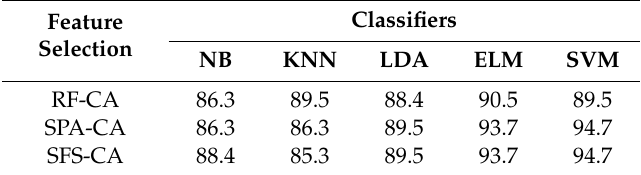
Table 2. The classification results of models based on the optimal wavelengths.